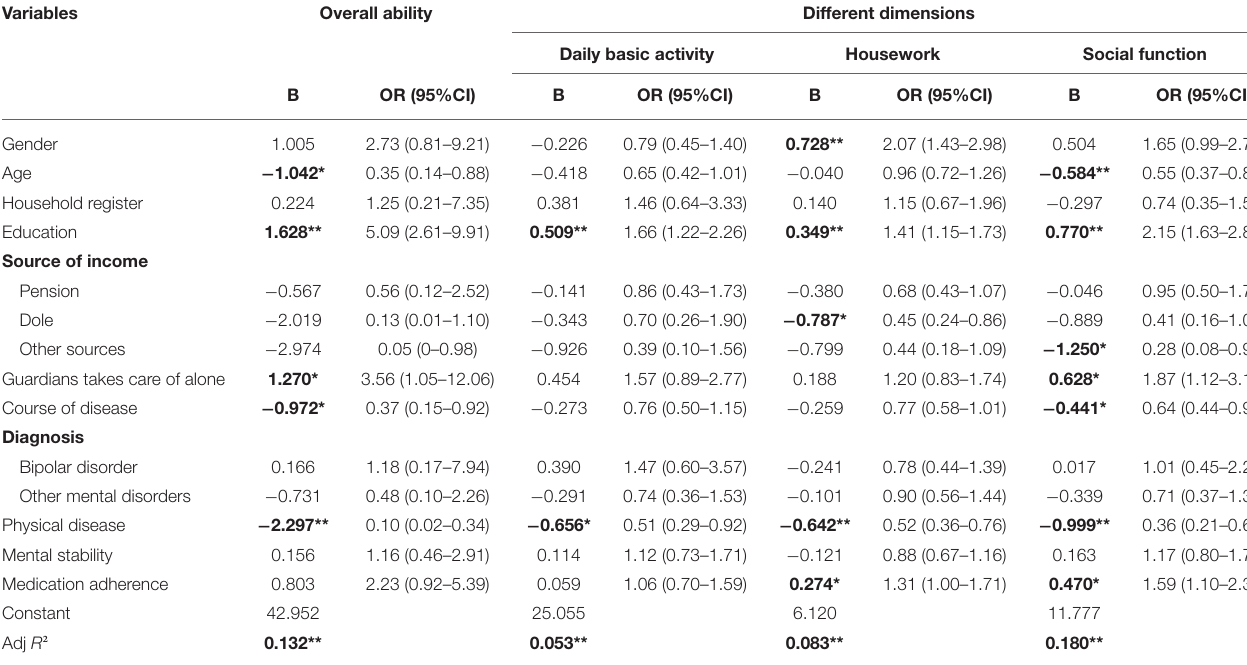
TABLE 3 | Multiple linear regression model